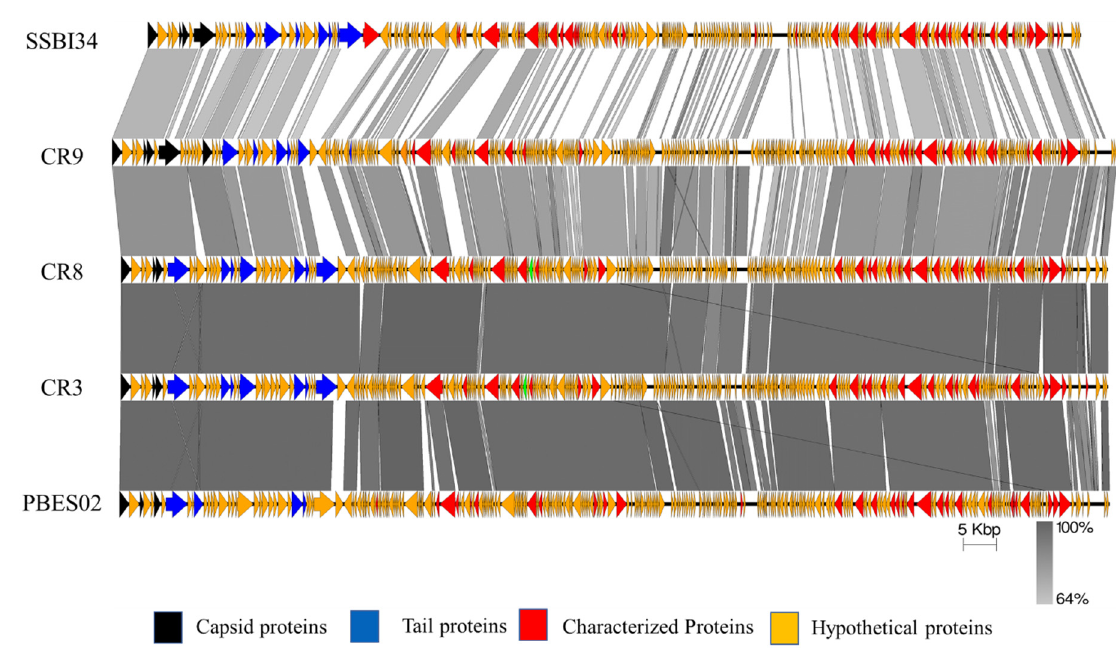
Figure 4. Easyfig homology diagram of SSBI34 with close phage relatives in NCBI using BLASTp. Various ORFs are color coded according to their putative function (scheme provided at the base of the figure).